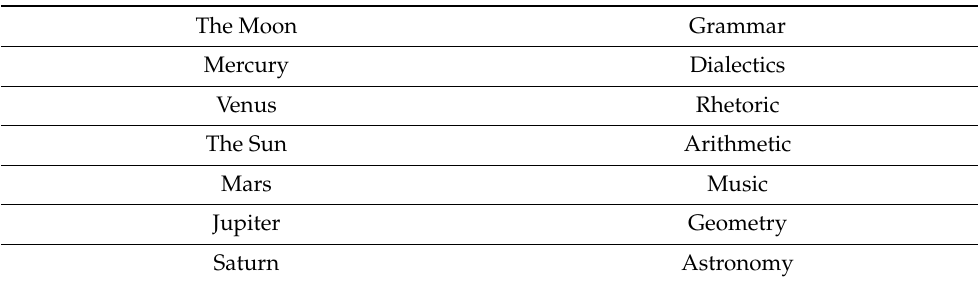
Table 1. The Correspondence of the Planets and the Liberal Arts in Dante Alighieri’s Convivio (Alighieri 1987, pp.